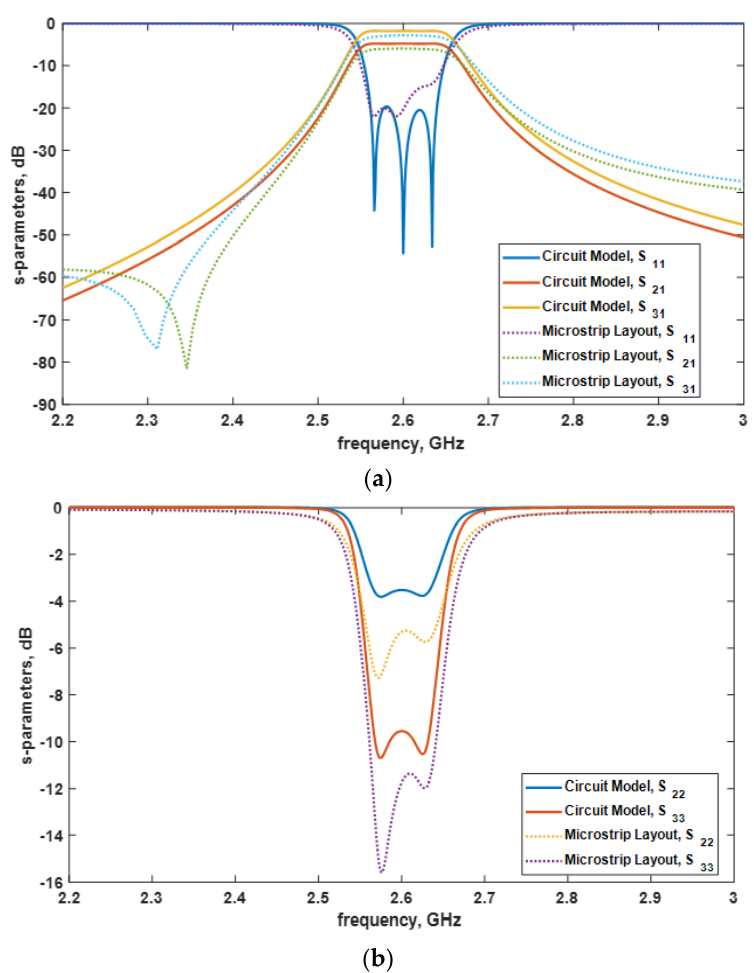
Figure 7. Comparison of the circuit model and the microstrip layout results ( a ) differential-mode responses and ( b ) single-ended output ports responses.